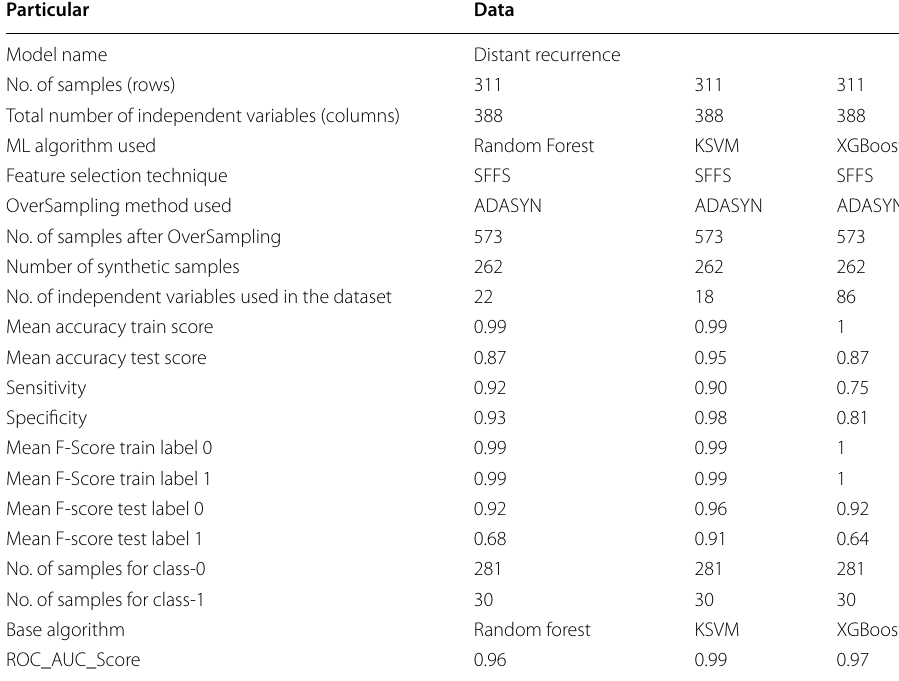
Table 7 Results of test dataset for distant recurrence